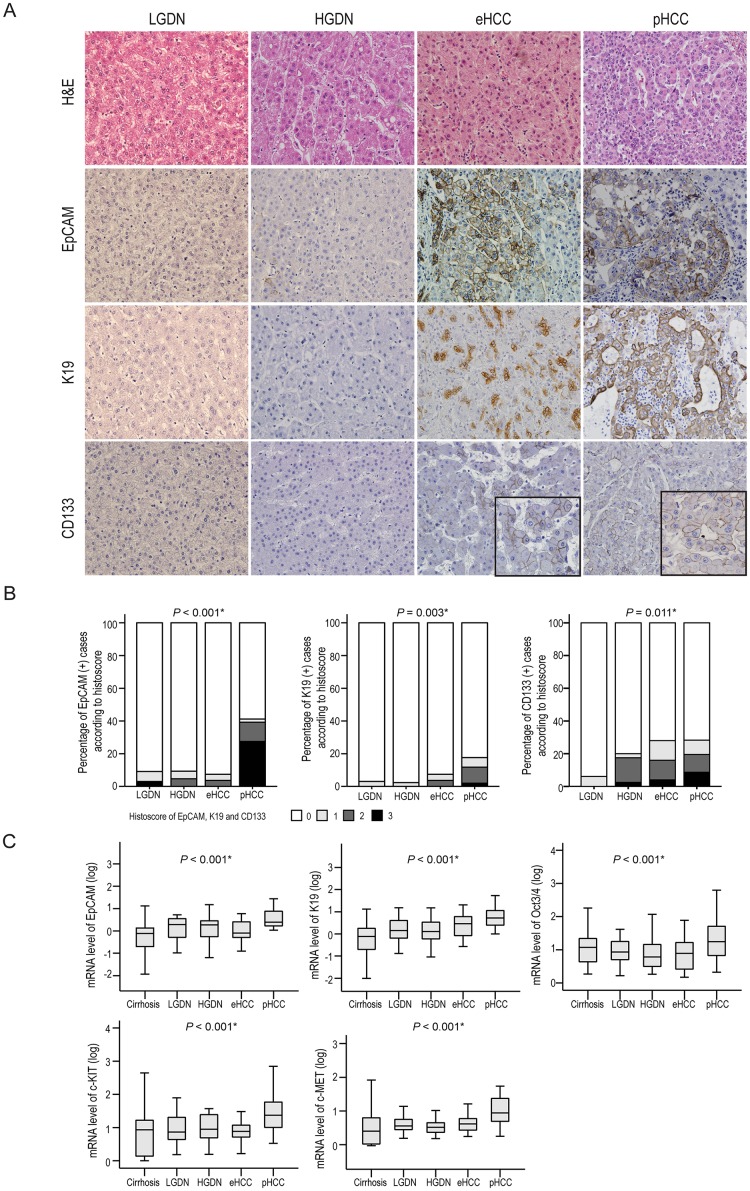
The expression of stemness features in B viral multistep hepatocarcinogenesis.A) Representative features of EpCAM, K19, and CD133 expression in LGDNs, HGDNs, eHCCs, and pHCCs are presented. Original magnification x200. Inset, high power magnification x400. B) Bar charts indicate the percentage of cases expressing EpCAM, K19, or CD133 protein in defined lesions of B viral multistep hepatocarcinogenesis. C) Box plots show the mRNA expression profiles of EpCAM, K19, Oct3/4, c-KIT, and c-MET in B viral multistep hepatocarcinogenesis. *Statistical significance (P <0.05).